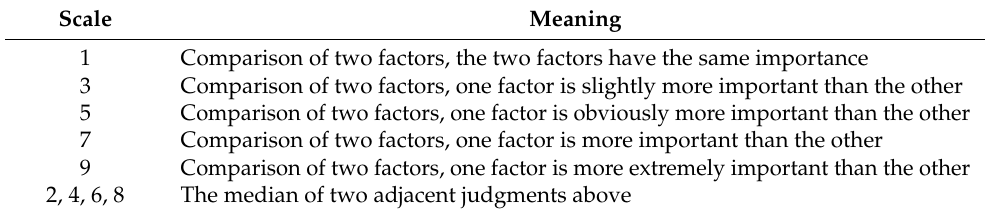
Table 1. Definition of scale of judgment